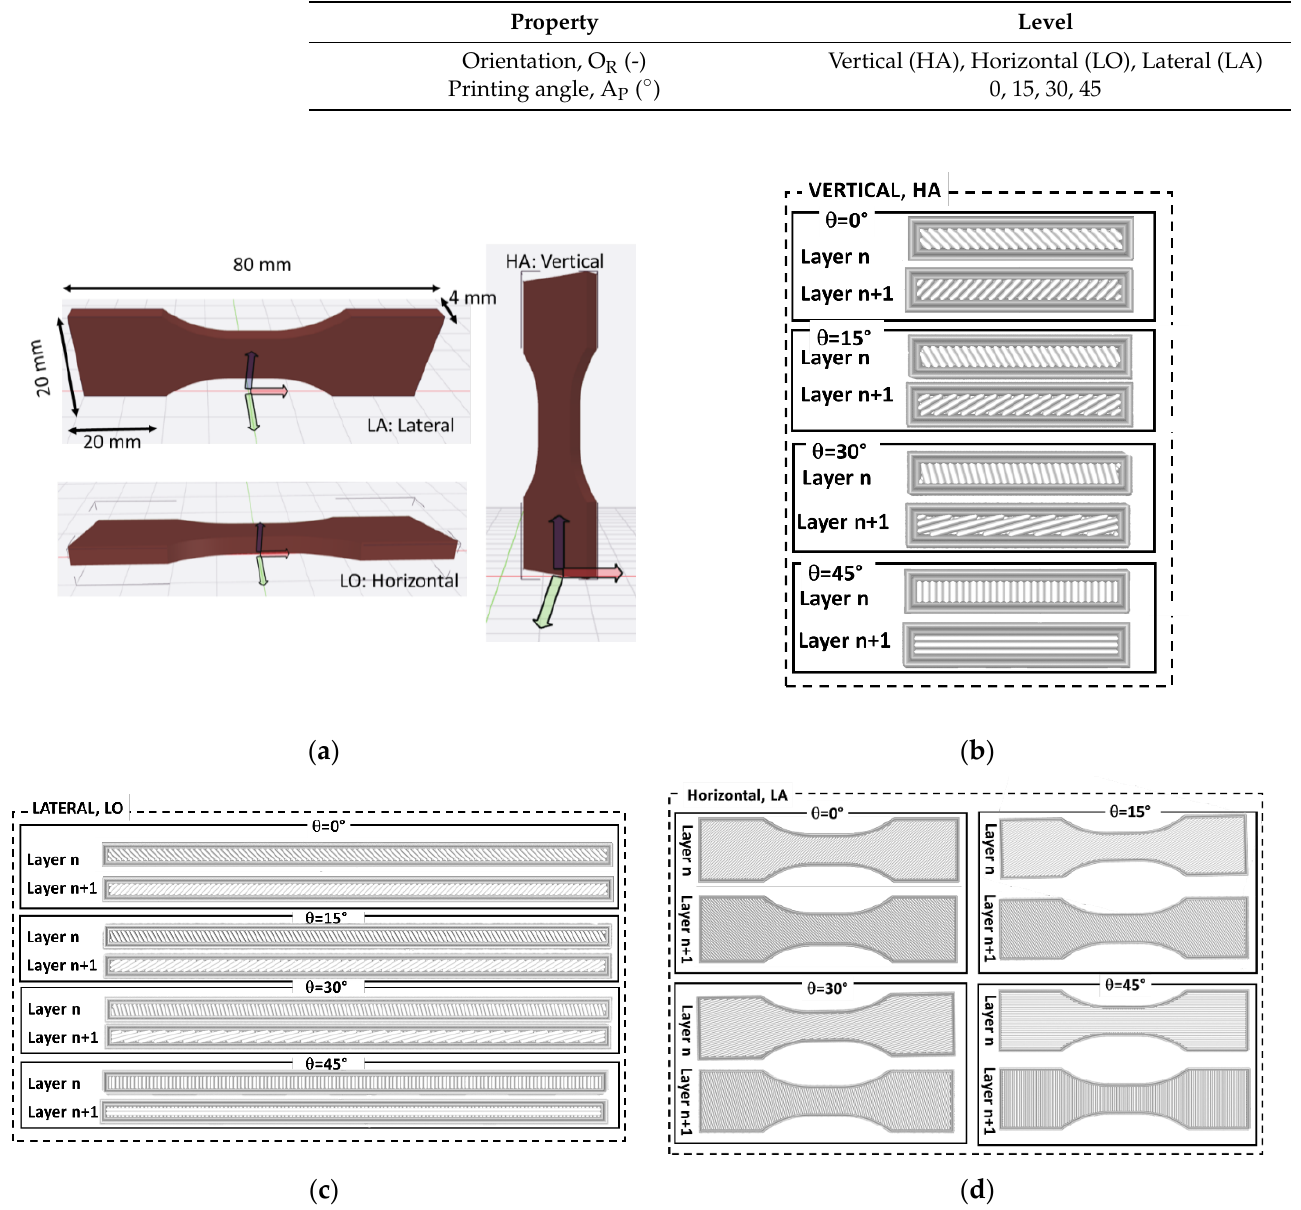
Figure 1. Illustration of the main printing parameters considered in this study: ( a ) Dogbone geometries and part orientation; and ( b ) printing angle combined with part orientation showing filament layups for vertical orientation; ( c ) layups corresponding to printing angles for lateral orientation; ( d ) horizontal orientation and related filament arrangement for all printing angles.